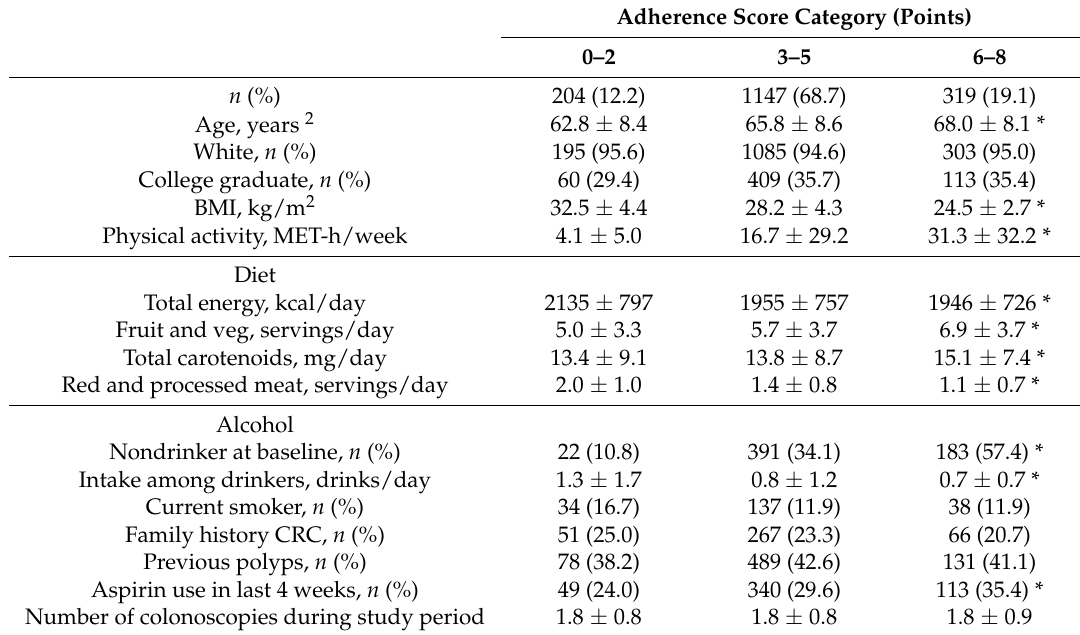
Table 2. Baseline characteristics of participants in the pooled sample, by categories of adherence 1